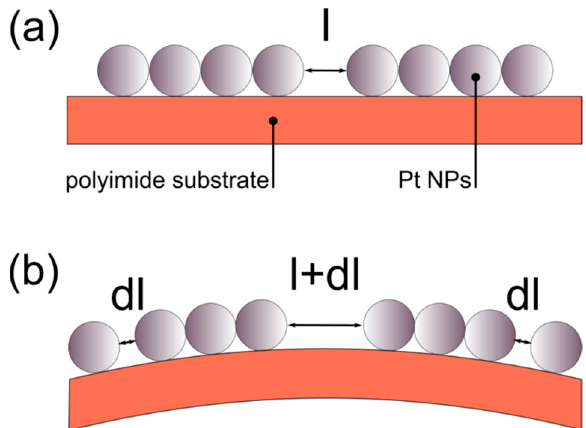
Figure 7. Graphic representation of inter-particle gaps between NP islands. At first there is a distance l ( a ) which after the appliance of strain is increased by dl, hence creating two additional gaps ( b ).